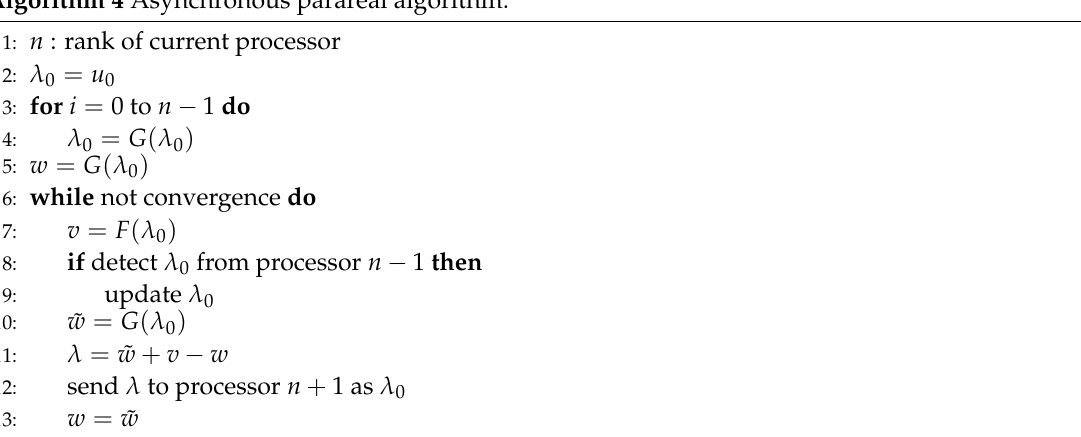
Algorithm 4 Asynchronous parareal